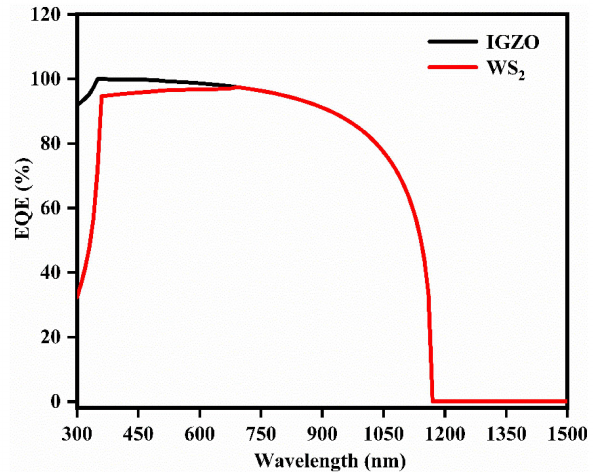
Figure 3. J-V Curve of WS 2 and IGZO ETL-based solar cell.